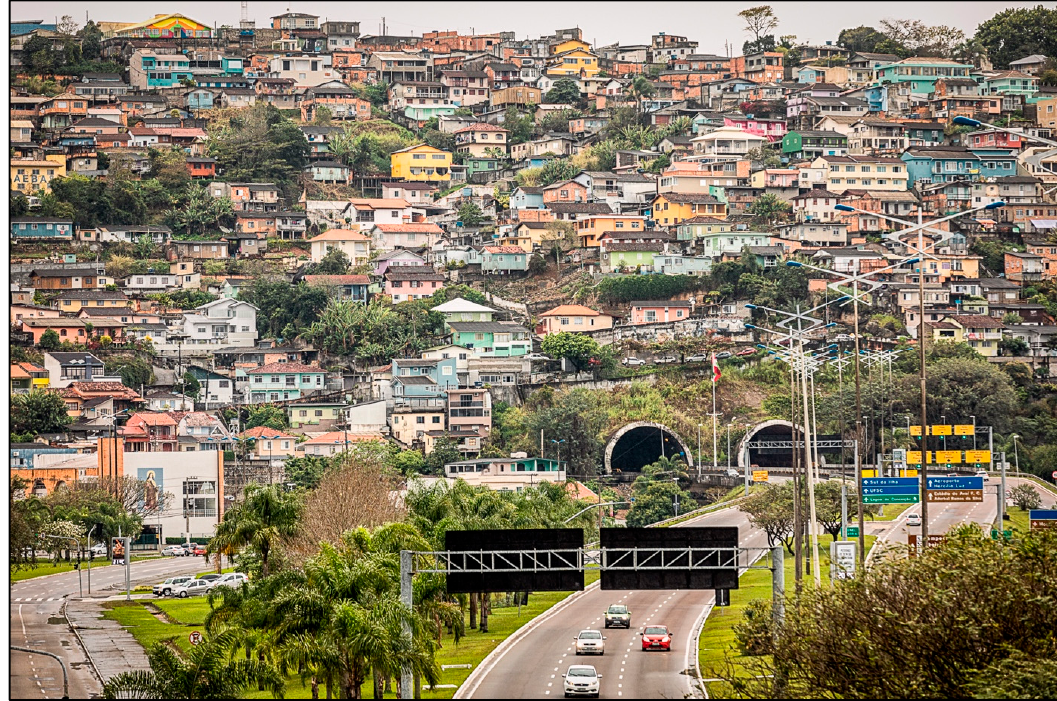
Figure 8. A view of the favelas, reproduced with permission from Eduardo Trauer (photo taken in February 2018).